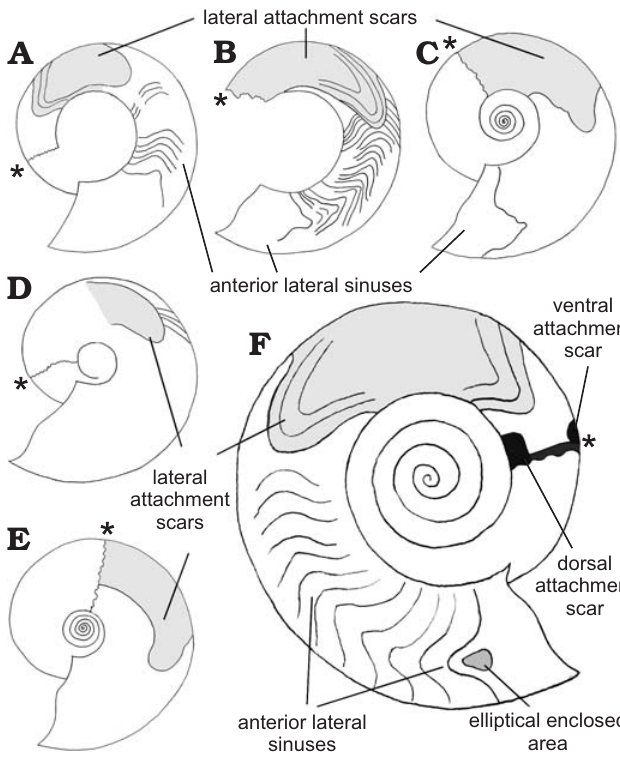
Fig. 2. Schemes of Kachpurites and Garniericeras muscle attachment scars. A , B . Kachpurites fulgens ; lateral attachment scars with enclosed apical part ( A , see also Fig. 10A) and without an apical border ( B , see also Fig. 6B). C . Kachpurites cheremkhensis ; lateral sinus and lateral attachment scars (see also Fig. 5A). D . Kachpurites subfulgens ; lateral attachment scars and partially-preserved lateral sinuses (see also Fig. 3A). E . Garniericeras ca- tenulatum with lateral (shifted to ventral side) attachment scars (see also Fig. 7B). F . United idealized scheme of the Kachpurites fulgens mantle attachment system. Asterisks mark the base of the body